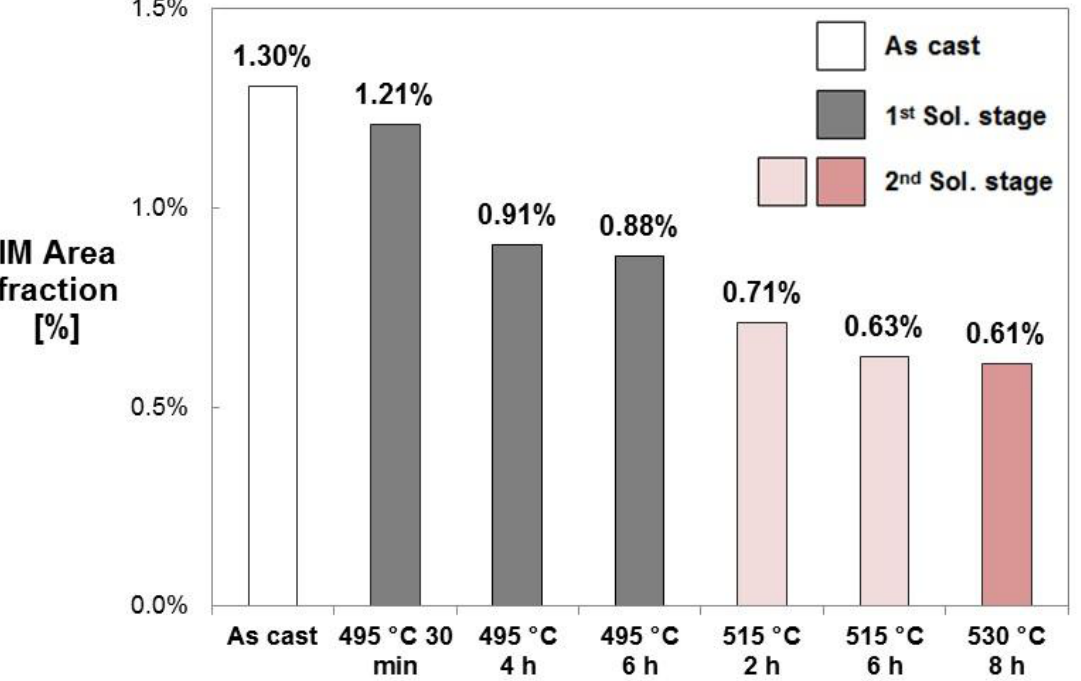
Figure 7. Average area fraction of intermetallics (IM) [%] calculated by SEM image analyses on A354 samples in different heat treatment conditions (as-cast, after the first solution stage at 495 ◦ C, and after different second solution stages at 515/530 ◦ C). This is re-adapted from Reference [21].